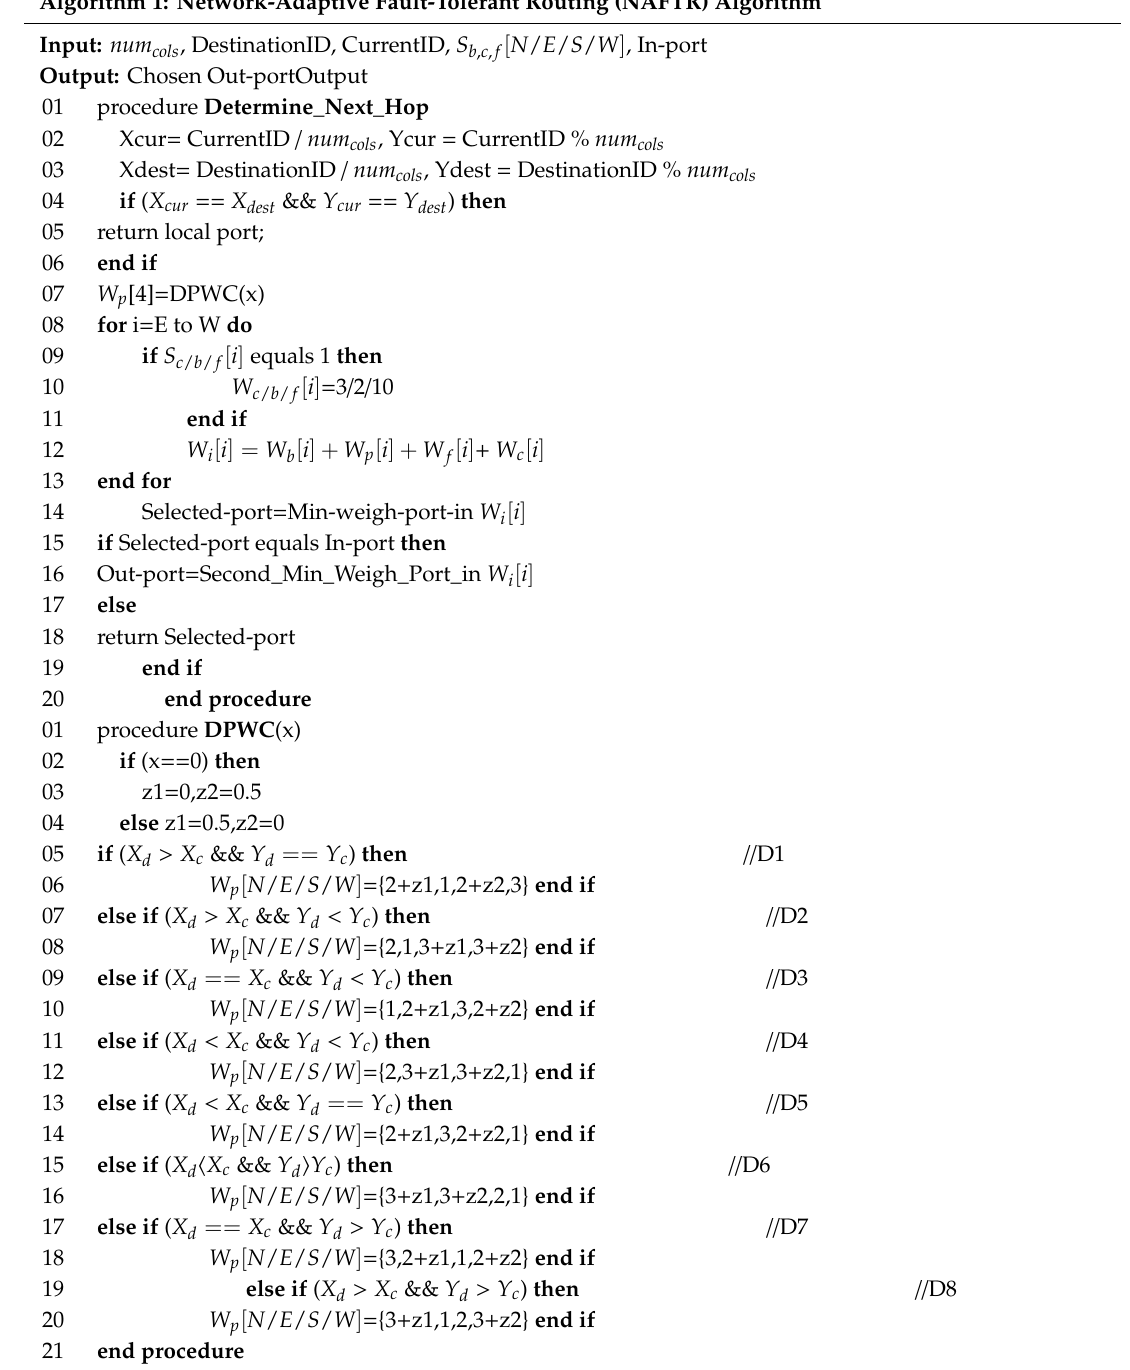
Algorithm 1: Network-Adaptive Fault-Tolerant Routing (NAFTR)